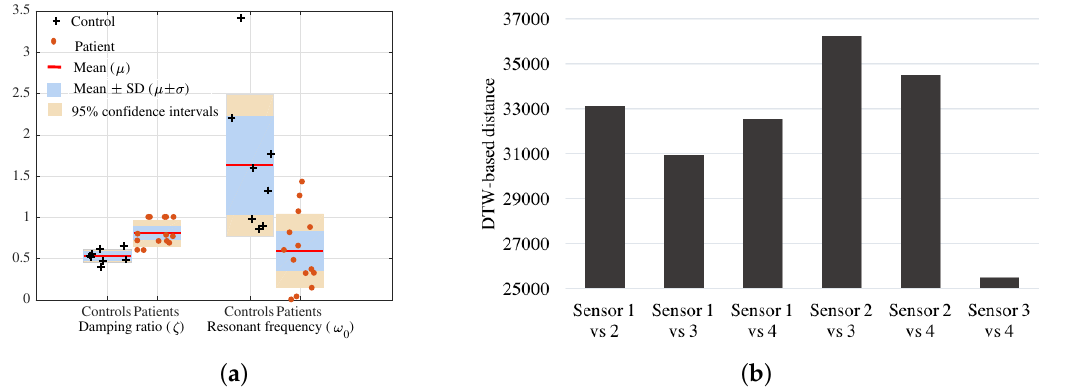
Figure 4. ( a ) Damping ratio ( ζ ) and resonant frequency ( ω 0 ) deduced from the pointing test; ( b ) distance between angular rate of each pair of sensors using dynamic time warping